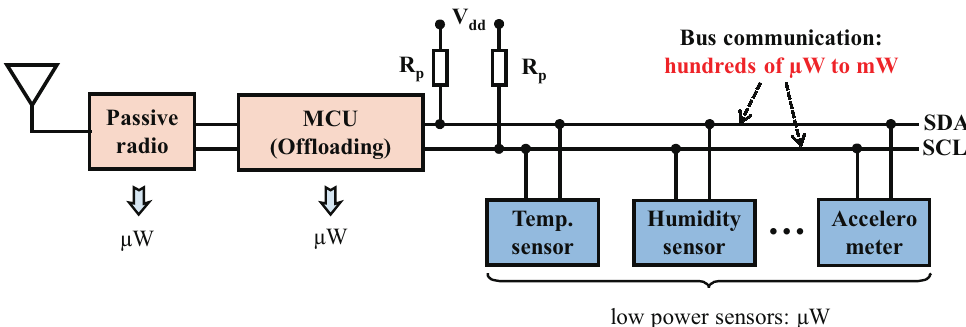
Figure 1. Although backscatter and offloading techniques could let components such as radio and the processor achieve ultra-low power, the bus communication to convey data among those components consumes significant power, which cannot be ignored in such backscatter